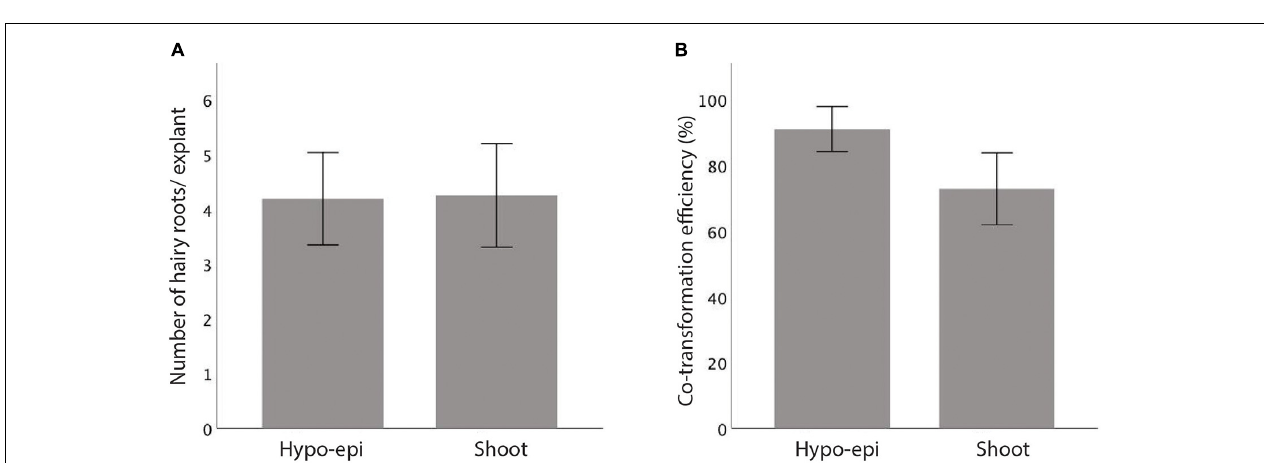
FIGURE 4 | In vitro hairy root induction comparison for vetch hypocotyl-epicotyl (Hypo-epi) and shoot after infected with R. rhizogenes K599. (A) An average number of hairy roots per explant formed 24 days after the infection. (B) Percentage of GUS expressing hairy root in total hairy root per explant (co-transformation efficiency, n = 40). Error bar: 95% CI. (A,B) No statistically significant at 0.05, t -test (SPSS statistics